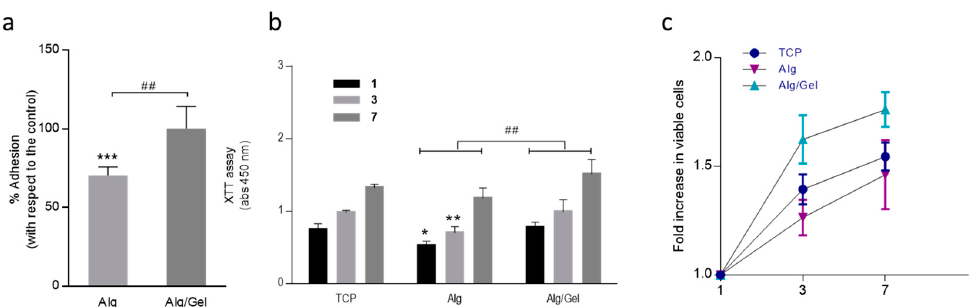
Figure 5. In vitro tests on Alg and Alg/Gel assembled scaffolds: ( a ) Adhesion and ( b ) proliferation (statistical difference * p < 0.05, ** p < 0.01, *** p < 0.001 respect to the control (TCP); ## p < 0.01 statistical difference between Alg and Alg/Gel); ( c ) cell viability fold increase in time. Cell proliferation was evaluated via XTT assay (Figure 5b). Results showed a signifi-